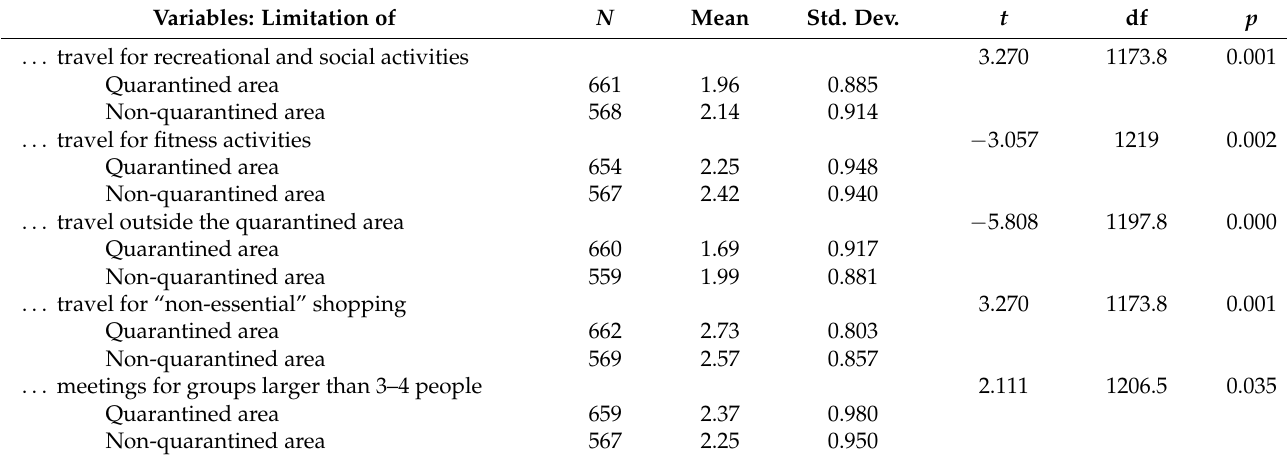
Table 5. Attitude towards the measures adopted by authorities and quarantined locality (Independent test